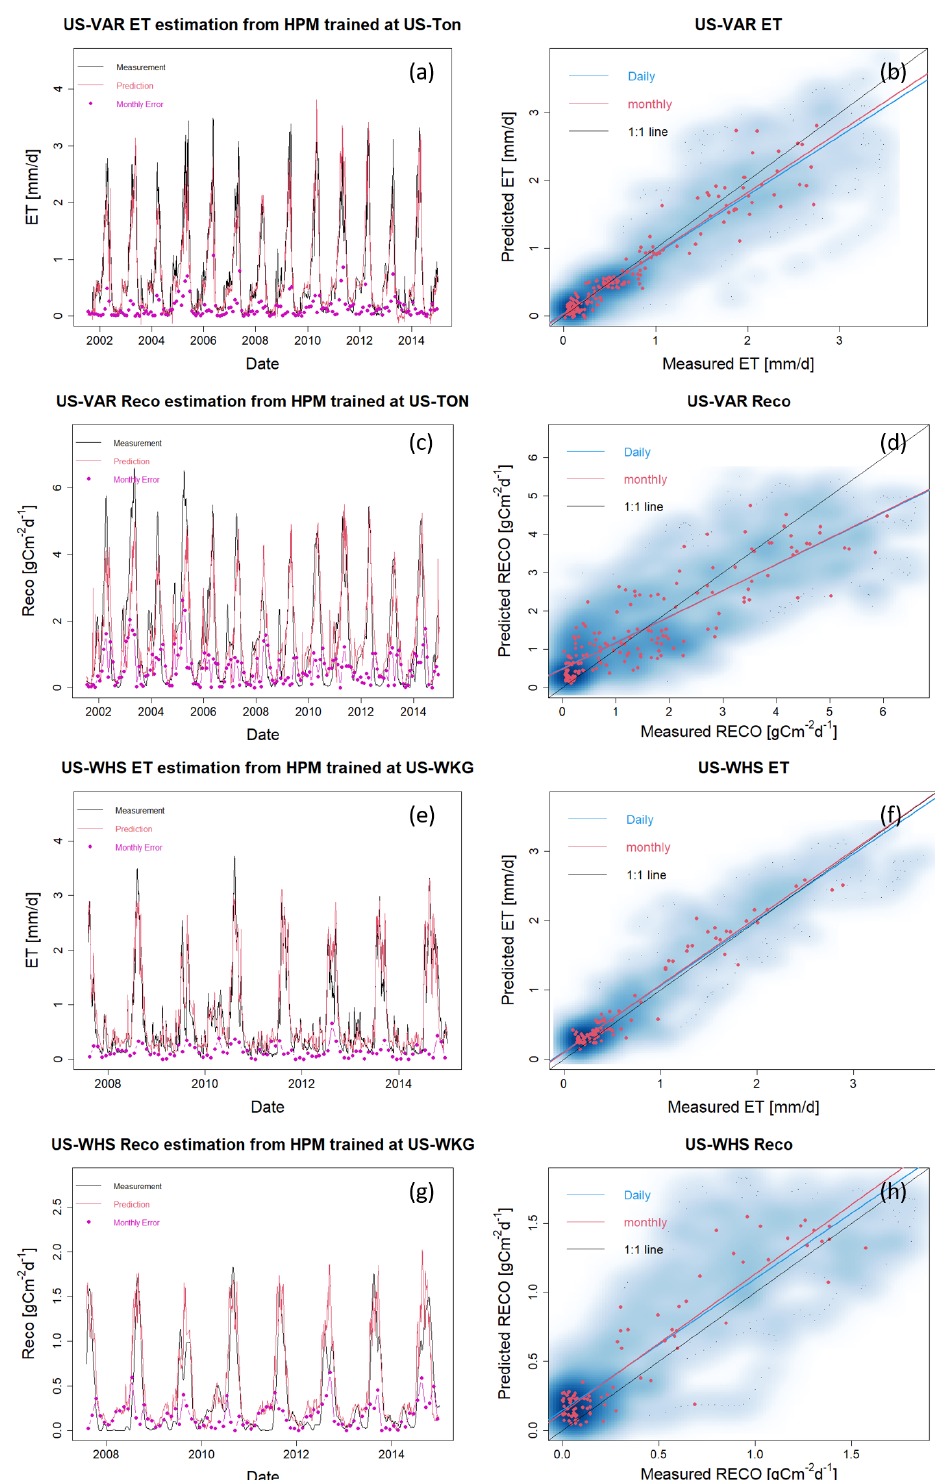
Figure A5. Use case 2. ET and R eco estimation at US-Var and US-Whs from HPM trained at US-Ton and US-Wkg, respectively.